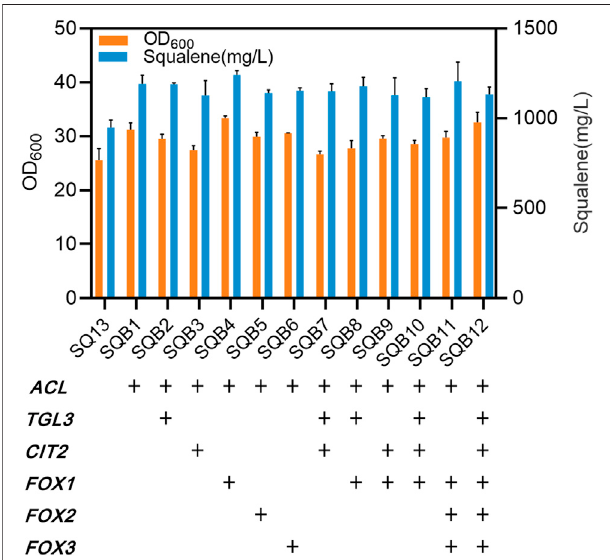
FIGURE 4 | Biomass concentrations and squalene contents of engineered strains after 96 h of culture. SQB1-SQB12 were modi fi ed from SQ13. + signs signify genes are strengthened. Error bars show SD